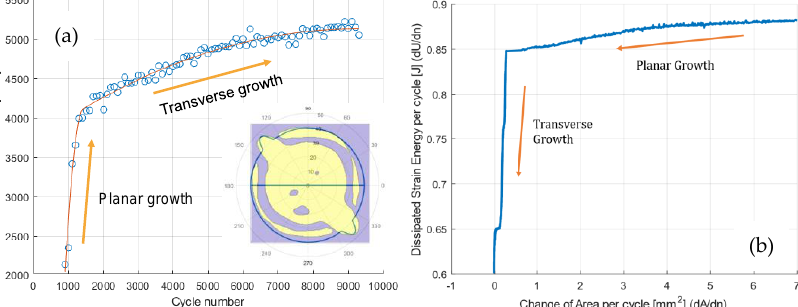
Figure 4. Fatigue delamination area propagation curve exhibiting a transition from planar to trans- verse growth ( a ) and the dissipated strain energy associated with the areal growth ( b ) [14].